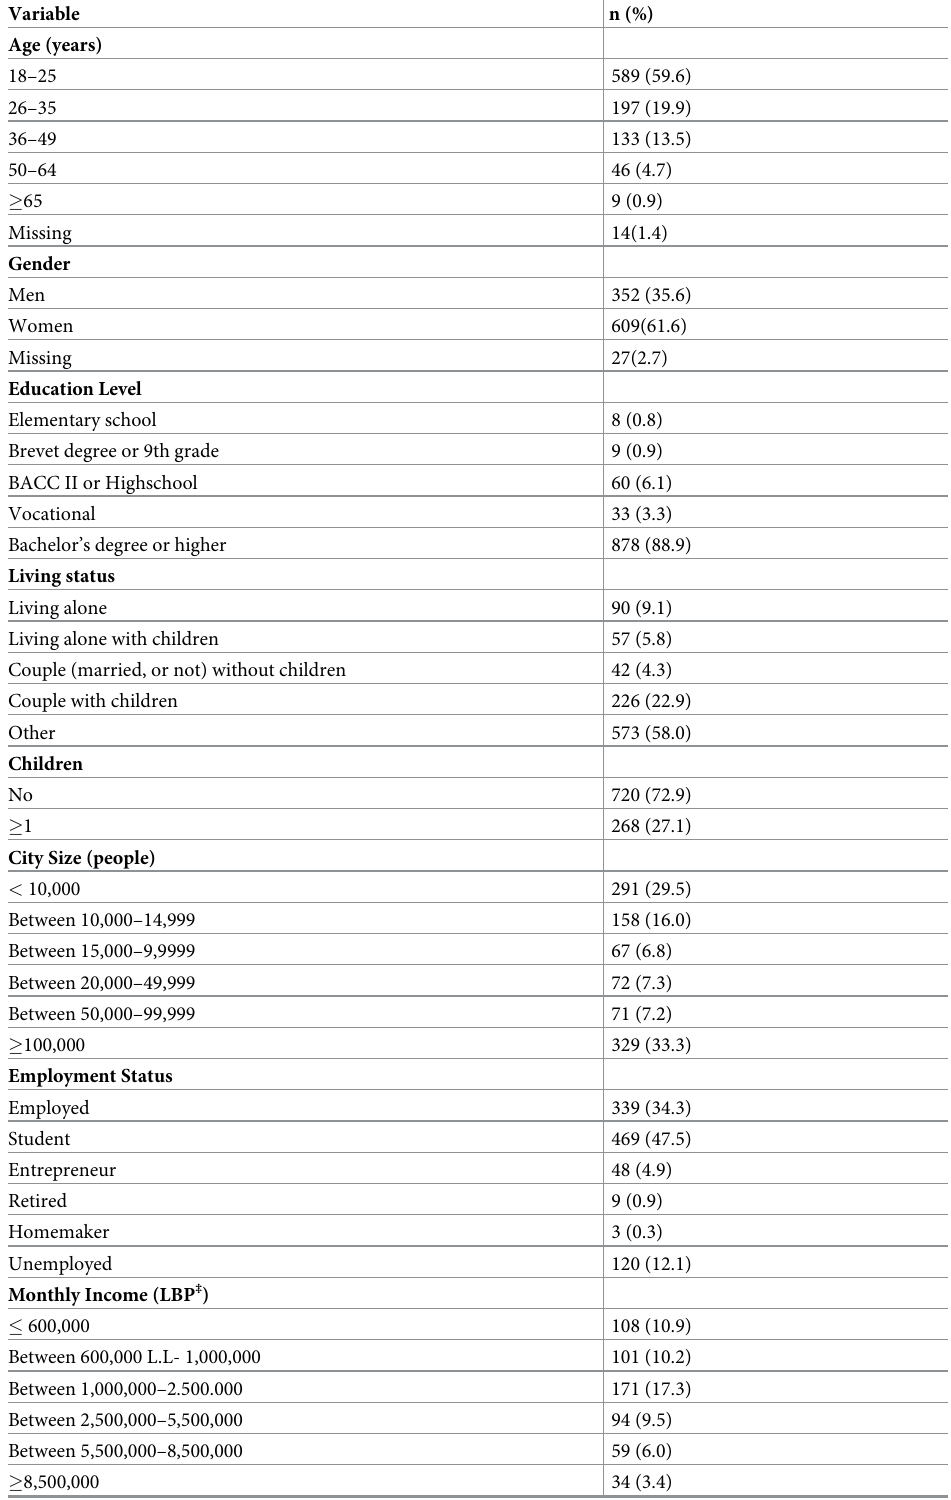
Table 1. Sociodemographic characteristics of the